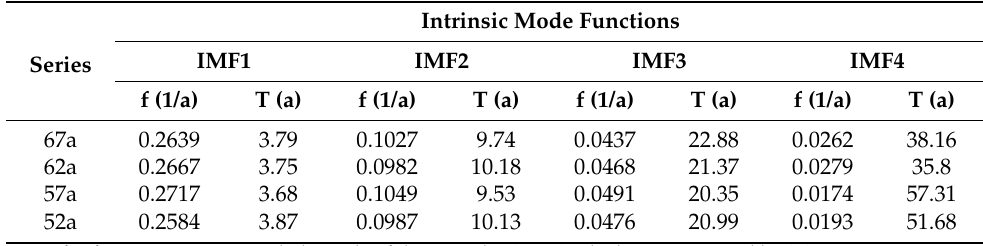
Table 2. The center frequencies and average periods of IMFs from annual series at Huayuankou station.